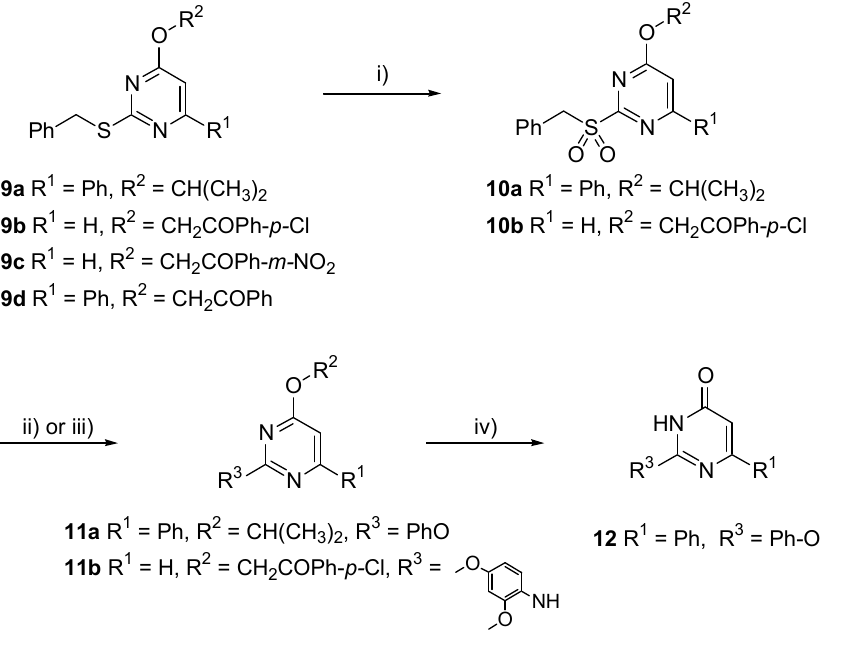
Scheme 5. Oxidation of 9 to the corresponding sulfone 10, nucleophilic displacement to produce the corresponding pyrimidines 11 , and displacement of the 4 ‐ isopropoxy group of 11a to yield 2 ‐ aryloxypyrimidinone 12 .